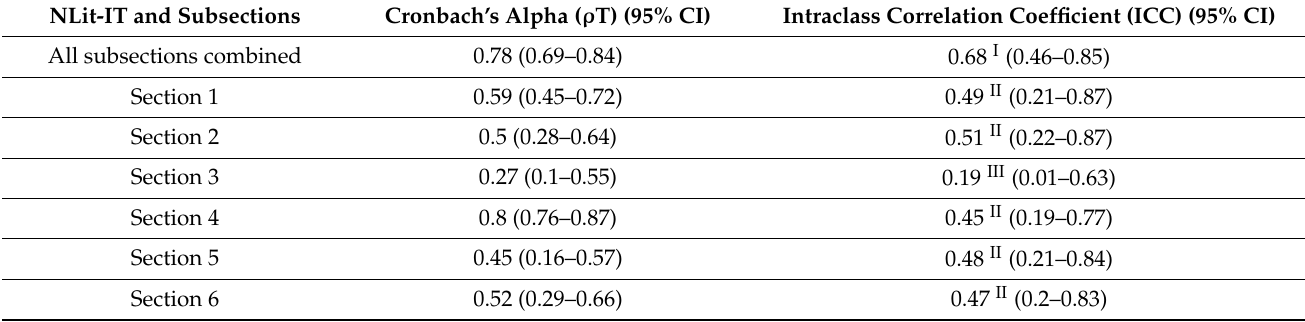
Table 3. Internal consistency and reliability of NLit-IT. Internal consistency was measured using Cronbach’s alpha and reliability was tested by way of intraclass correlation coefficient (ICC) (Test-retest).